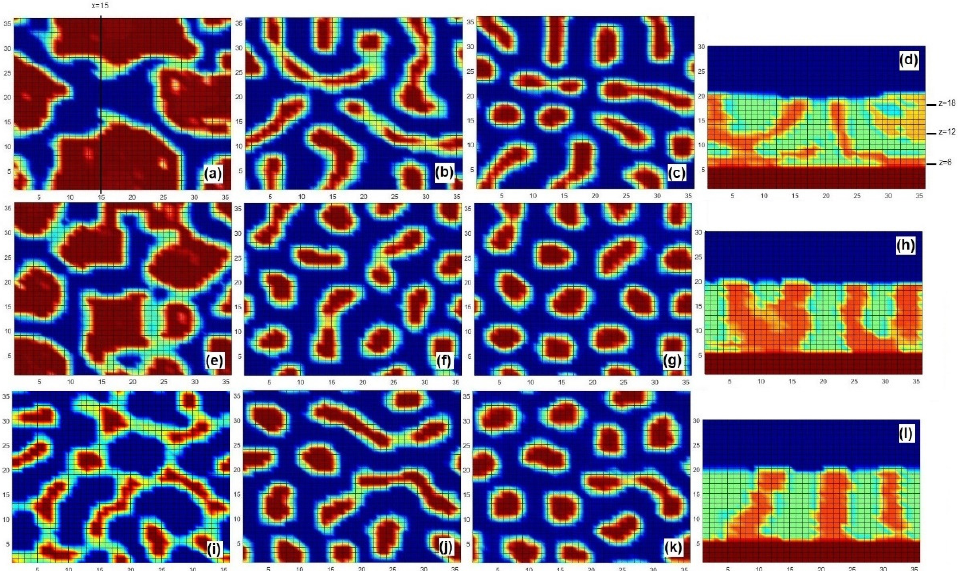
Figure 1. Horizontal cross sections through the planes z = 6 ( a , e , i ), z = 12 ( b , f , j ), and z = 18 ( c , g , k ) and vertical cross sections through the plane x = 15 ( d , h , l ) obtained with the following diffusion coefficient values of component A on substrate material: D AS = 8.8 × 10 − 17 m 2 /s ( a – d ), D AS = 2.2 × 10 − 17 m 2 /s ( e – h ), and D AS = 8.8 × 10 − 19 m 2 /s ( i – l ).